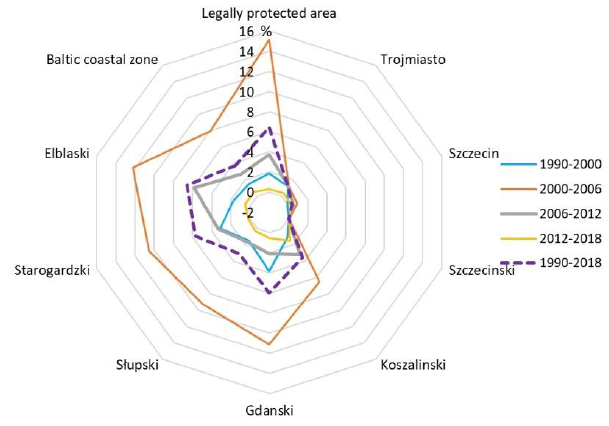
Figure 13. Long and short-term diversity of land consumption rate (LConR) across the Polish Baltic coastal zone and regions.